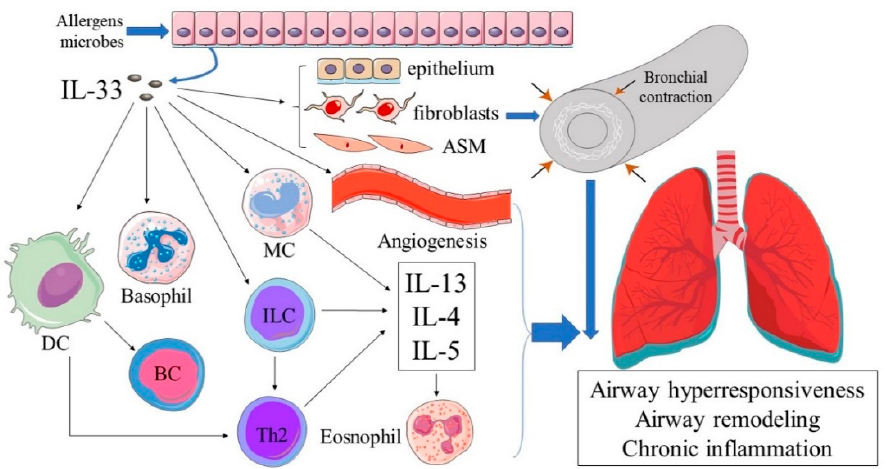
Figure 2. IL-33 in asthma pathology. IL-33 is involved in the initiation and perpetuation of airway hyperresponsiveness (AHR), airway remodeling and inflammation in asthma process. hyperresponsiveness (AHR), airway remodeling and inflammation in asthma